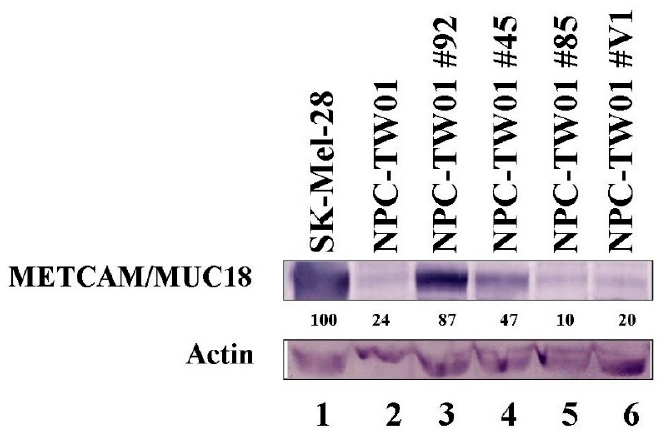
Figure 1. Expression of the huMETCAM/MUC18 protein in the G418 R -NPC-TW01 clones. HuMETCAM/MUC18 expression in the lysates prepared from the various clones/cells was determined by Western blot analysis, as described in the Section 4. The HuMETCAM/MUC18 expression level in the cell lysate of a human melanoma cell line, SK-Mel-28, was used as a positive control (lane 1) and that from the parental human nasopharyngeal cancer cell line, NPC-TW01, was used as a negative control (lane 2). The HuMETCAM/MUC18 expression in the cell lysates from three huMETCAM/MUC18 cDNA-transfected NPC-TW01 clones (clones #92, #45, and #85) and one vector control clone (#V1) are shown in lanes 3–6. The number under each lane indicates the relative level of huMETCAM/MUC18 in each cell line, assuming that that of the SK-Mel-28 was 100%. Actin is shown as the loading control.